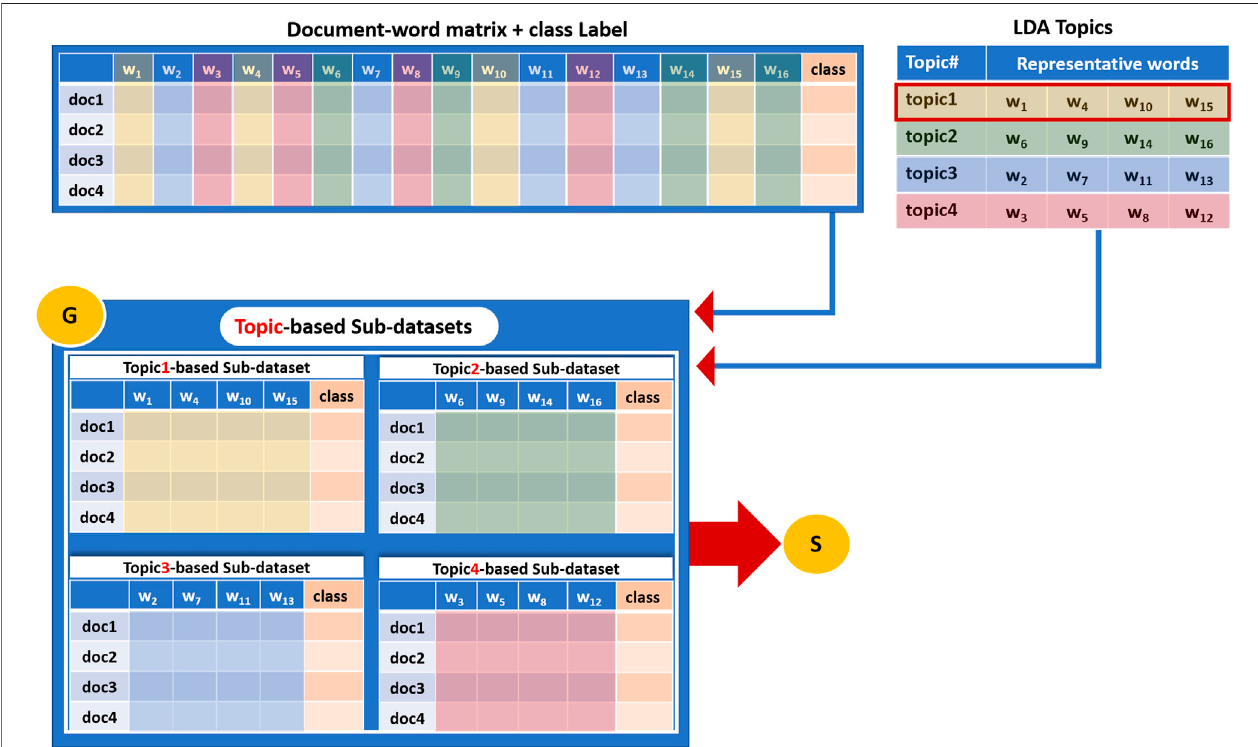
FIGURE 4 | An example of how a sub-dataset is generated based on terms that belong to a topic and then subjected to the Scoring Component S.